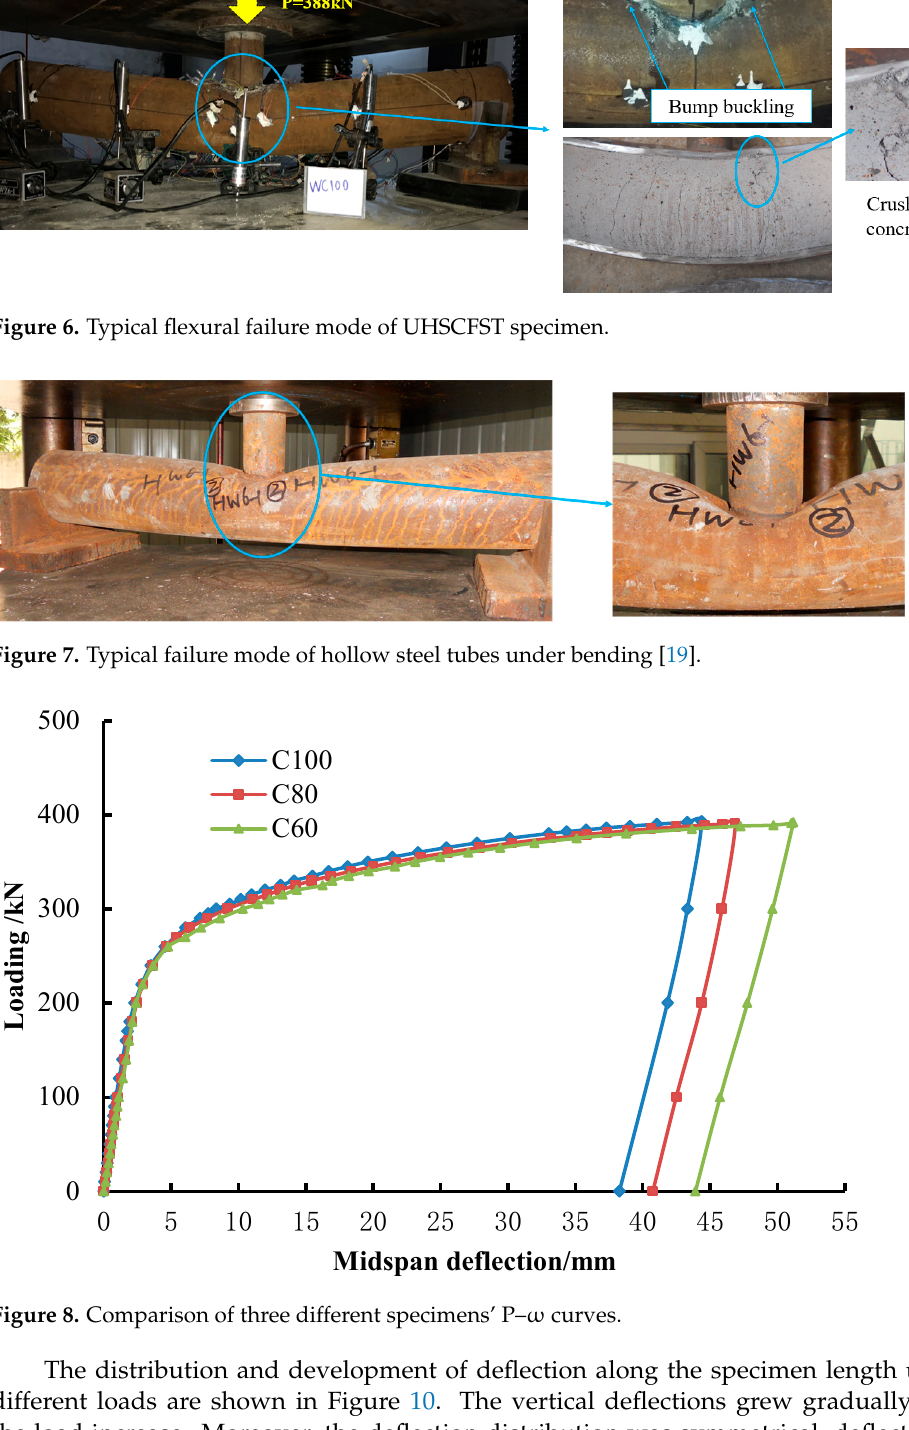
( b ) Hollow steel tube (D × T = 127 × 6 mm) Figure 9. Comparison of deflection at the top and bottom of sections. ( a ) Group W5 − C60 ( b ) Group W5 − C80